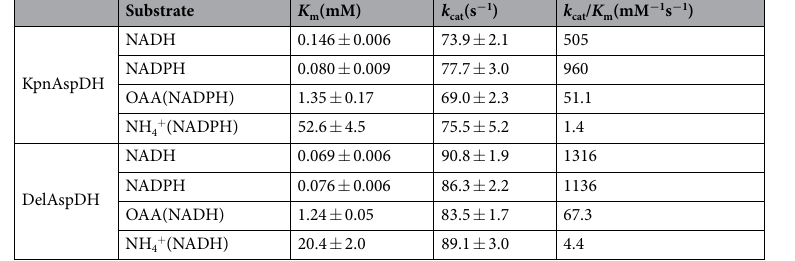
Table 4. Kinetic parameters of the KpnAspDH and